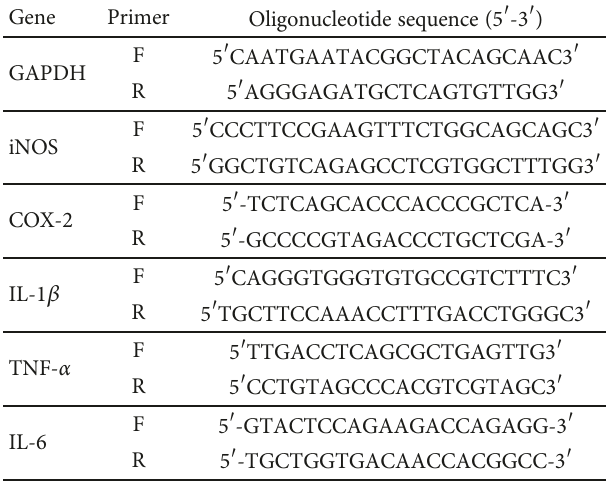
Table 1: Sequence of primers used for RT-PCR for B. hebetor venom gene